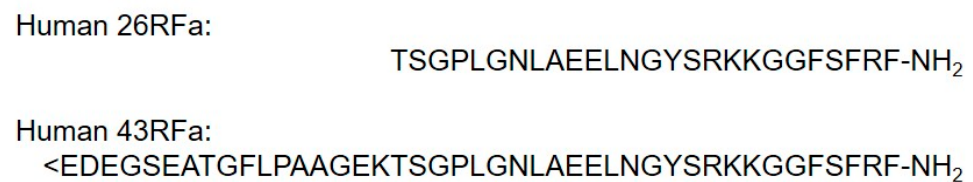
Figure 1. Primary structures of human 26RFa and 43RFa/QRFP. <E denotes pyroglutamic acid.